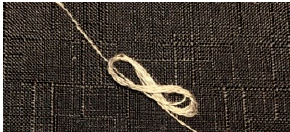
Figure 3. Schoeller 100% Inox NM 22/2.